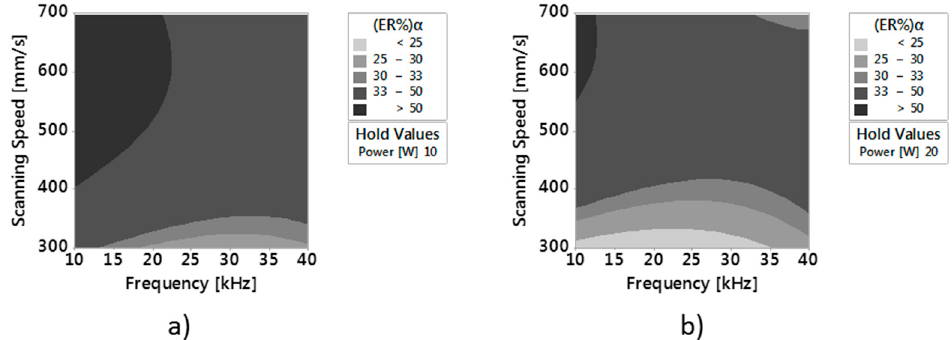
Figure 9. ( a ) Contour Plot of (ER%) α versus v and F p at constant Power of respectively 10 W and ( b ) 20 W.